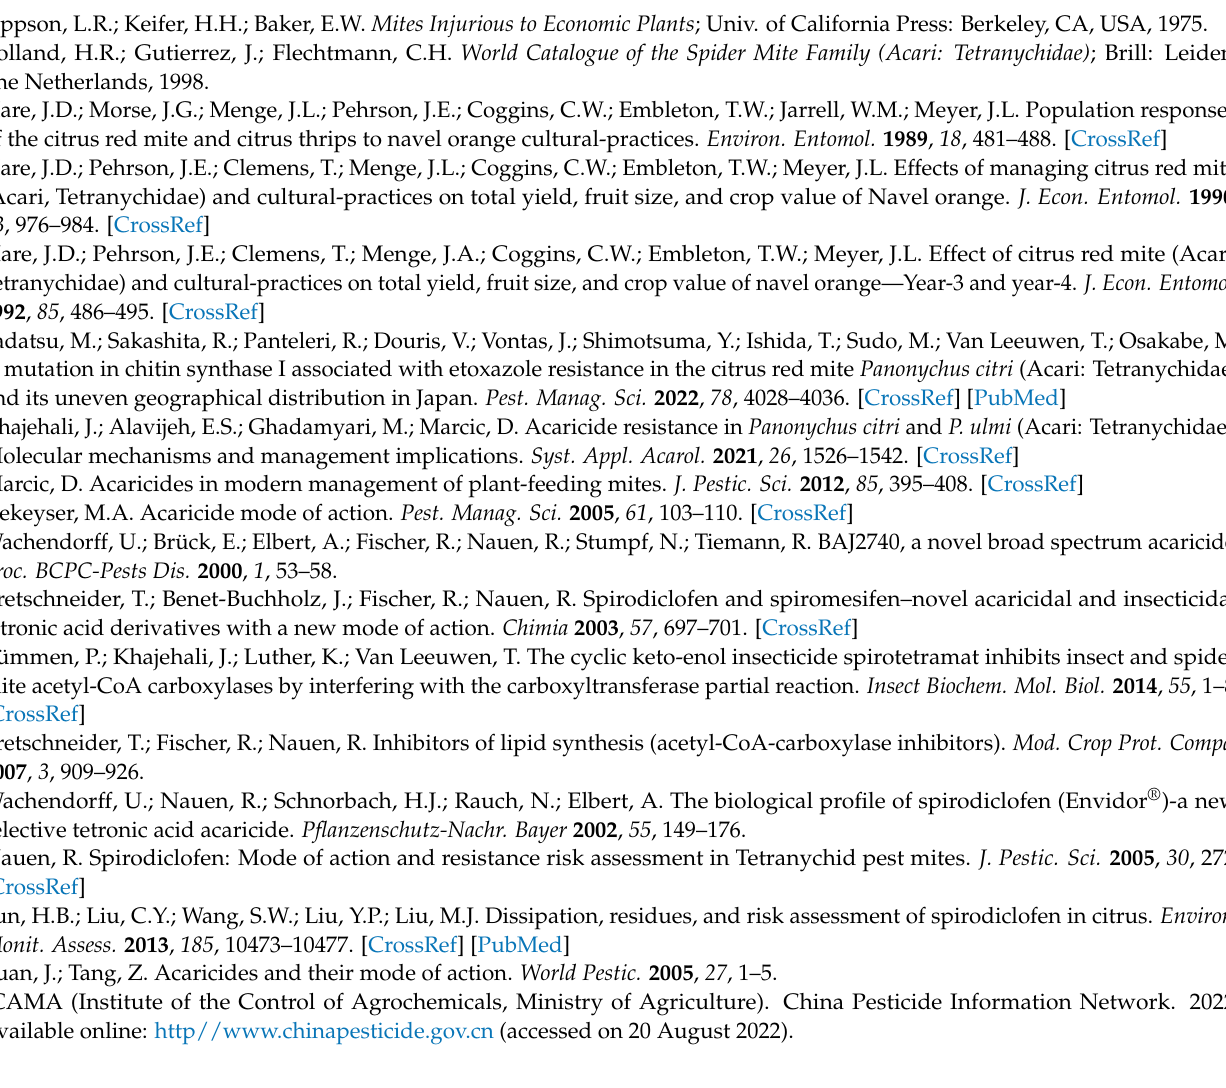
Table S2. Gene primers for RT-qPCR and RNAi. Figure S1. DiffExp genes statistics. Figure S2. Level 2 GO terms of